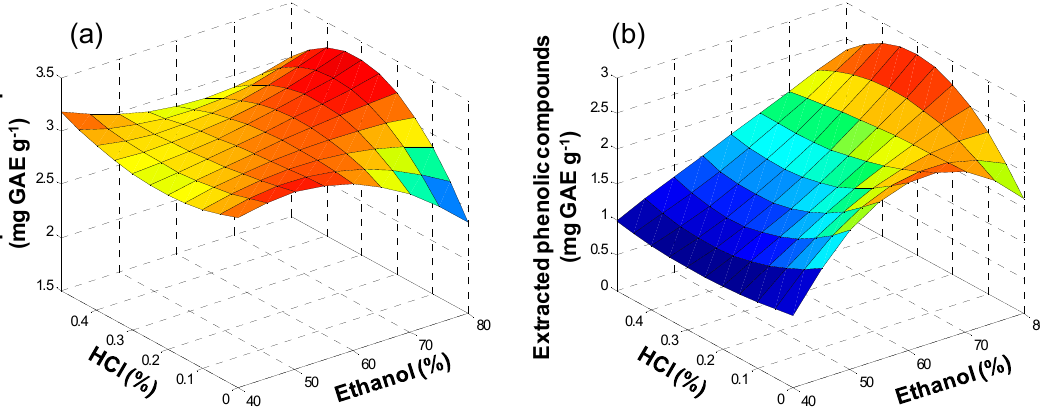
Figure 1. Response surface plots for extracted phenolic compounds (mg GAE g − 1 ) in ( a ) olive pomace and ( b ) lees filters by UAE as a function of ethanol (%) and HCl (%) concentration.